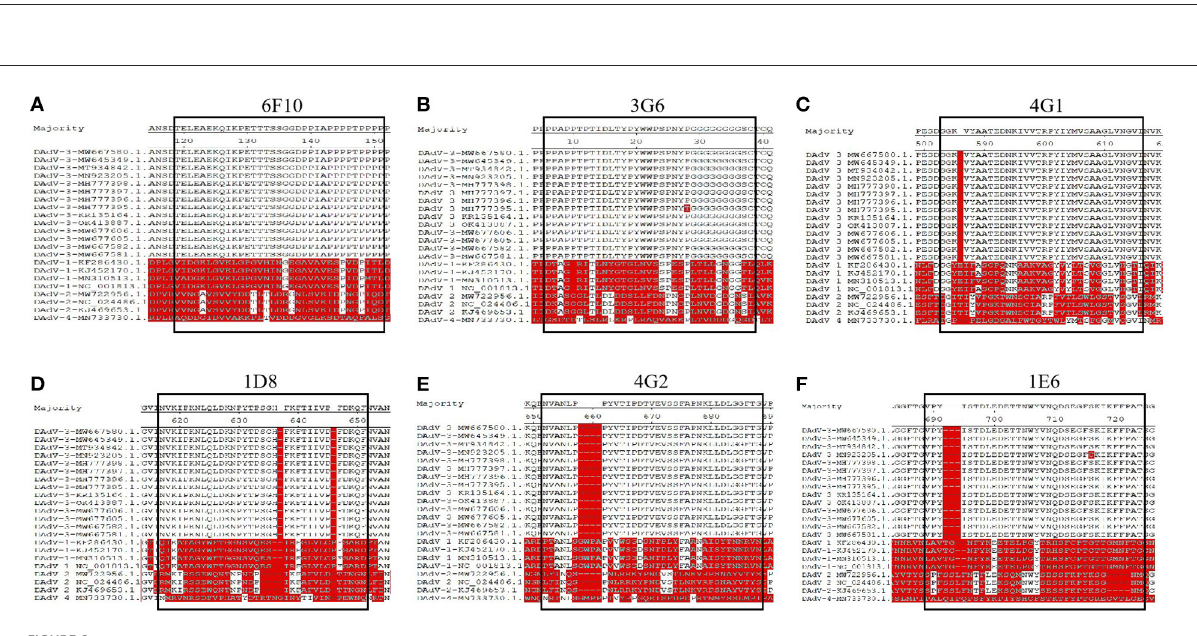
FIGURE6 Sequence alignment analysis for the identified epitopes in Fiber-1. The amino acid sequence analysis of the epitopes recognized by 6F10 (A) , 3G6 (B) , 4G1 (C) , 1D8 (D) , 4G2 (E) , 1E6 (F) with different DAdV-3 and other representive DAdV